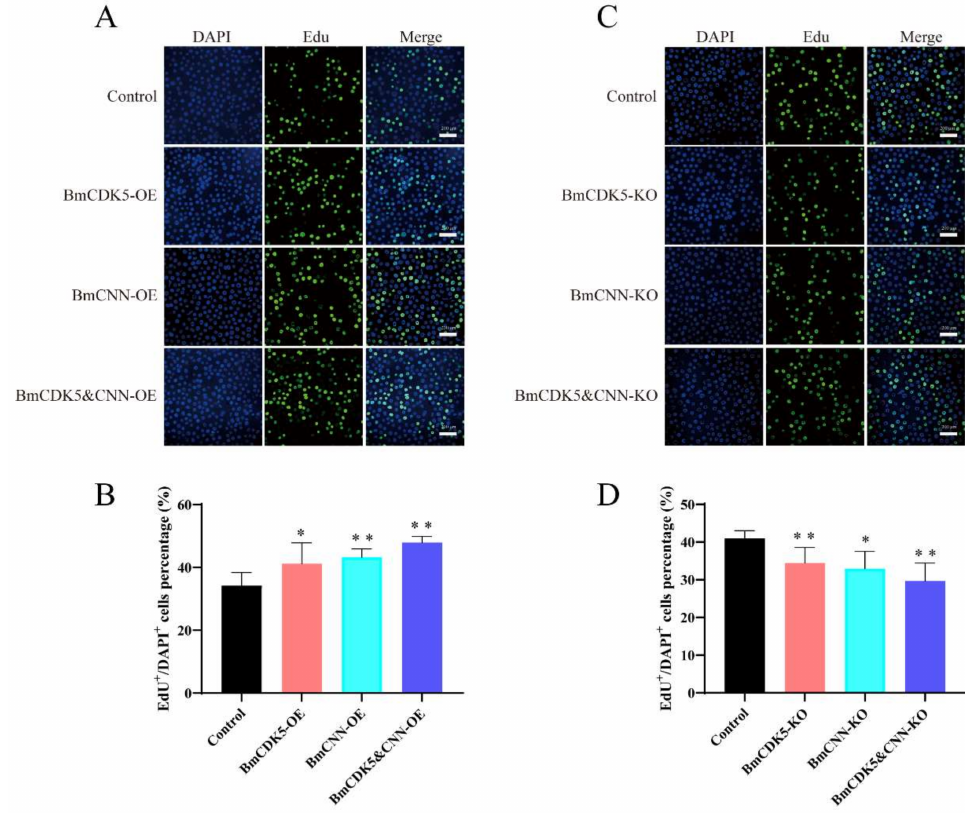
Figure 7. Cell proliferation regulated by BmCDK5-BmCNN complex in BmNS cells. ( A , C ) The EdU labeling experiment in BmNS cells. ( B , D ) Statistical analysis of EdU positive or EdU + cells (* 0.01 ≤ p < 0.05, ** p <